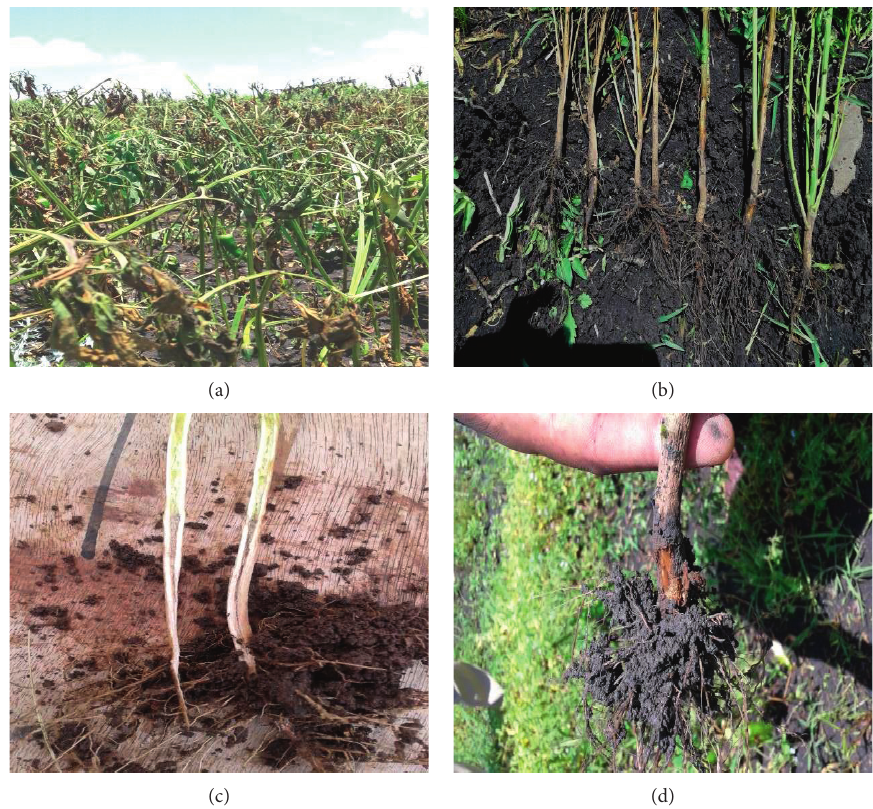
Figure 3: Field work sample pictures showing disease severity and symptom. (a) Fusarium wilt symptom on leaves. (b) Fusarium wilt symptom on the external stem. (c) Fusarium wilt systemic symptom. (d) Symptom on a root. Table 4: Disease susceptibility evaluation after inoculation of F. oxysporum and R. solanacearum on local pepper (no. of seedlings used per cultivar was 60).